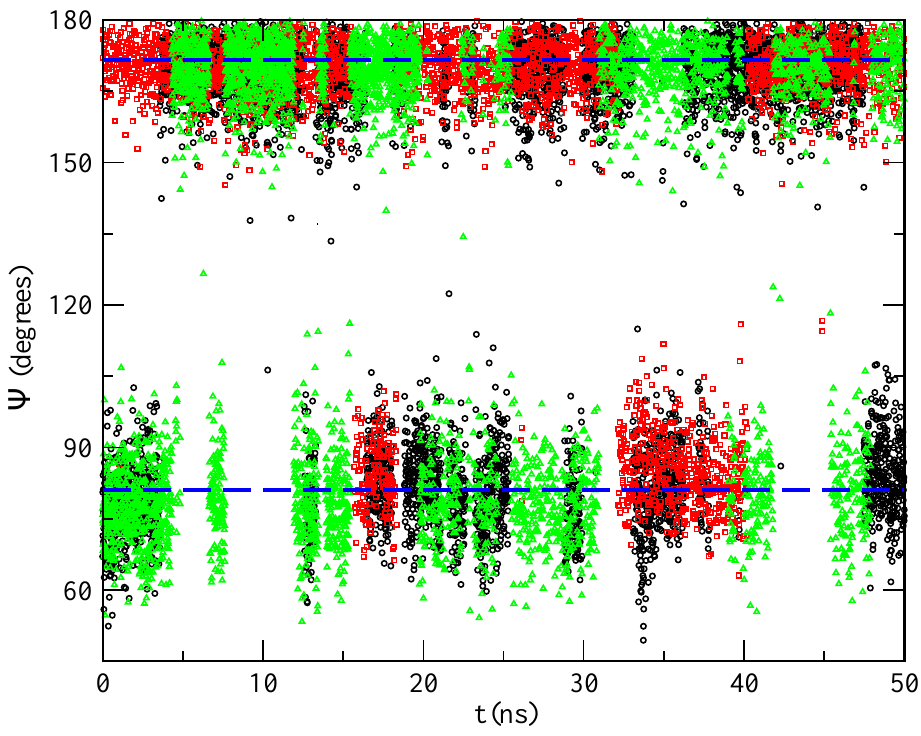
Figure 7. Angular distributions for the selected dihedral angle Ψ as a function of simulation time. Percentages of cholesterol are: 0% (black circles), 30% (red squares), and 50% (green triangles). The dashed lines indicate average values and are a guide for the